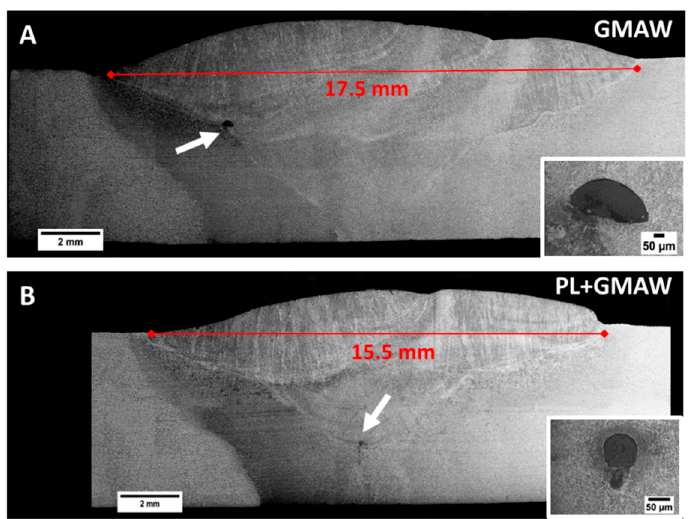
Figure 3. Macrographs of the weld seams made of GMAW ( A ) and PL + GMAW ( B ) conditions. In detail, the micrographics show the defects as indicated by the arrows.